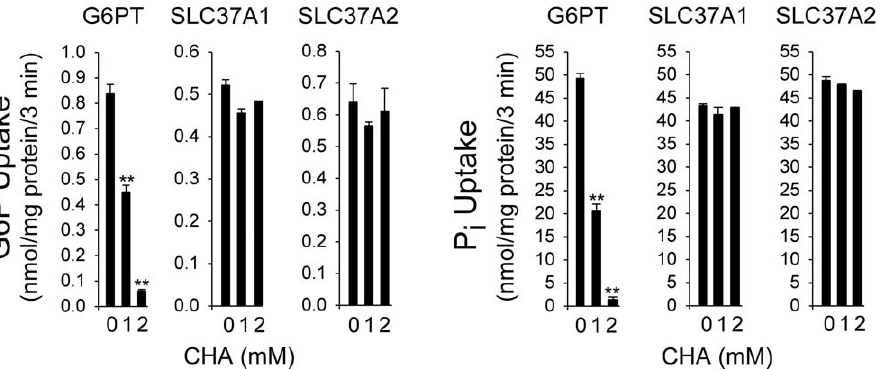
Figure 4. Effects of CHA on antiporter activity of SLC37A1 and SLC37A2. Proteoliposomes were reconstituted from detergent solubilized microsomal membrane extracts expressing SLC37A1, or SLC37A2 and were loaded with 50 mM P i as described under Materials and Methods. The 50 mM P i -loaded G6PT proteoliposomes were used as a control. Results shown are from three independent experiments, each point determined in triplicate. Data are presented as the mean 6 SEM. ** p , 0.005.